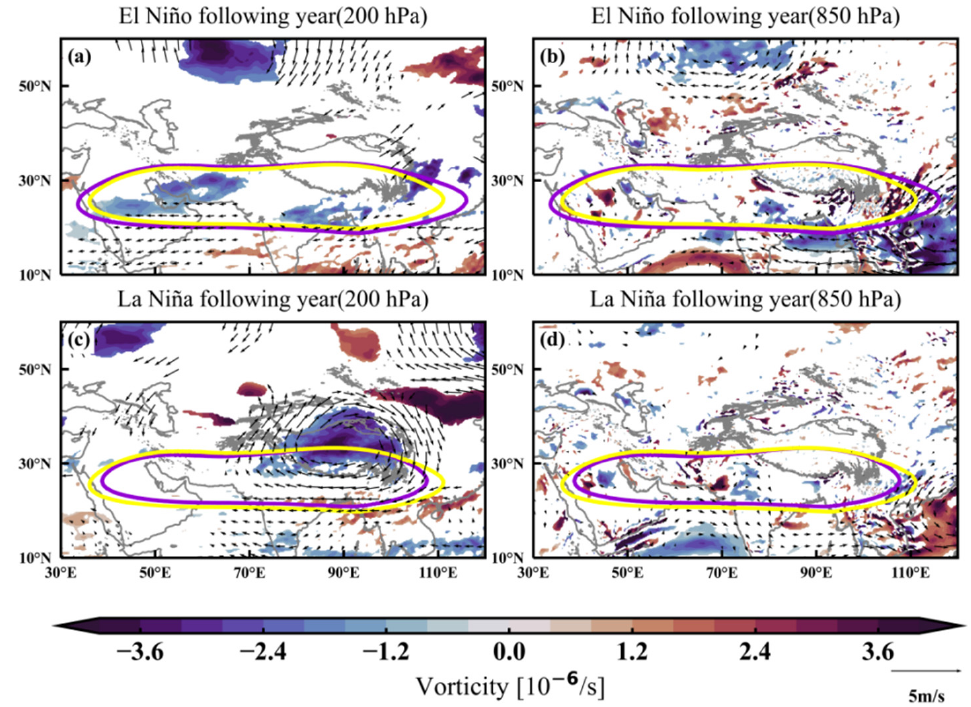
Figure 5. Composite wind anomalies at 850 hPa and 200 hPa (arrows, unit: m/s), with the SAH region averaged (solid yellow lines, 12,520 gpm, geopotential height isolines), and relative-vorticity anomalies (shading, unit: 10 − 6 /s) in the summers following El Niño and La Niña. ( a ) El Niño at 200 hPa, ( b ) El Niño at 850 hPa, ( c ) La Niña at 200 hPa, ( d ) La Niña at 850 hPa. The solid purple lines indicate the climatological location of the SAH region. The results above the 95% confidence level ( t -test) are indicated.